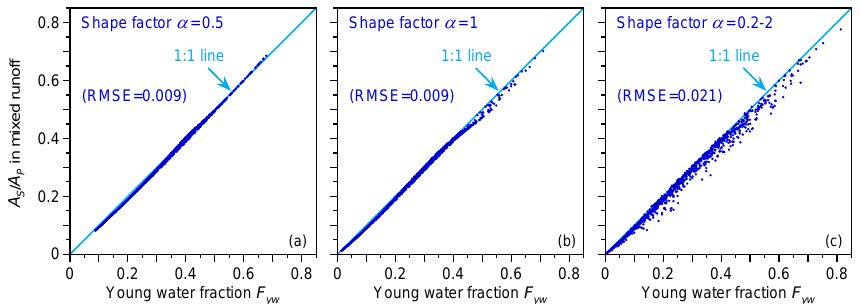
Figure 11. True and apparent young water fractions for the same 1000 synthetic catchments shown in Fig. 7. The tracer cycle amplitude ratio in the combined runoff of the two subcatchments (vertical axes) corresponds closely to the average young water fraction in the combined runoff (horizontal axes). As in Fig. 7, each synthetic catchment comprises two subcatchments with individual MTTs randomly chosen from a uniform distribution of logarithms spanning the interval between 0.1 and 20 years, and with each pair of MTTs differing by at least a factor of 2. In (a) and (b) , all subcatchments have the same shape factor α . In (c) , shape factors for each subcatchment are randomly chosen from a uniform distribution between α = 0.2 and α = 2.